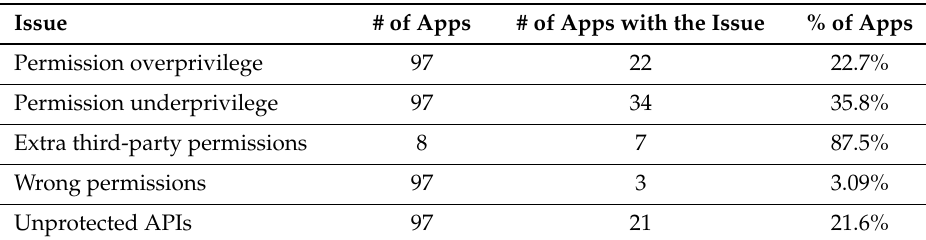
Table 3. Permission-related issues detected in open source projects.